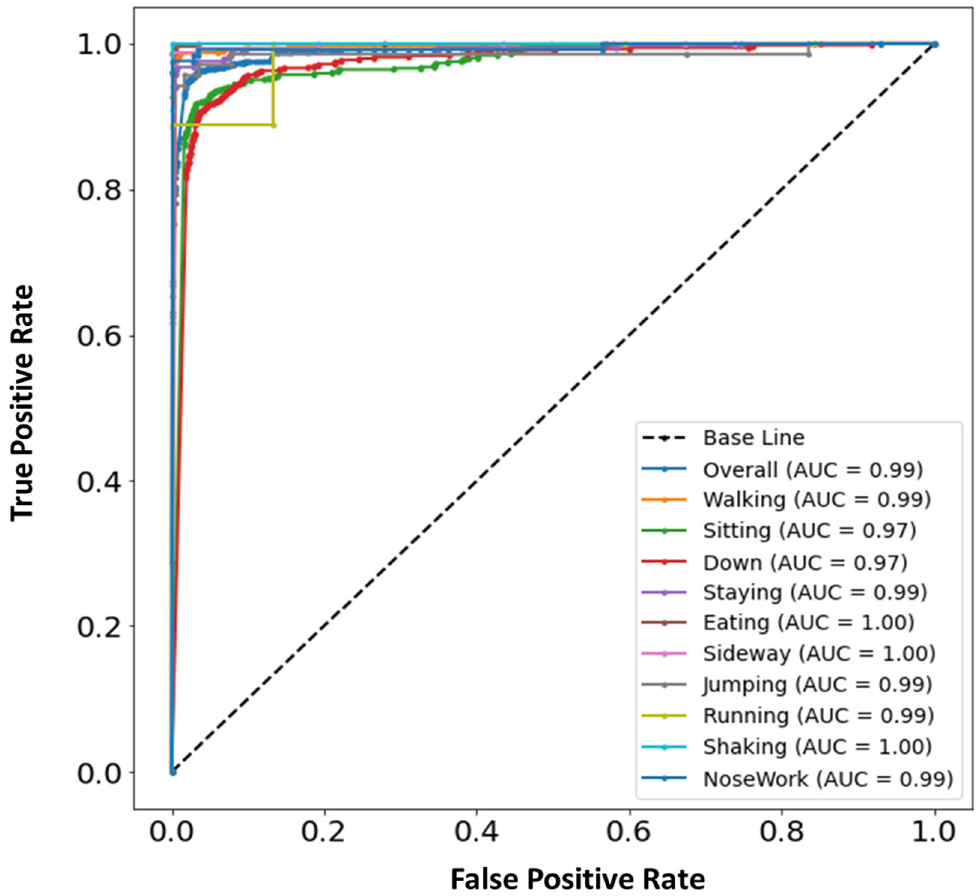
Figure 4. The ROC-AUC curves for each class.